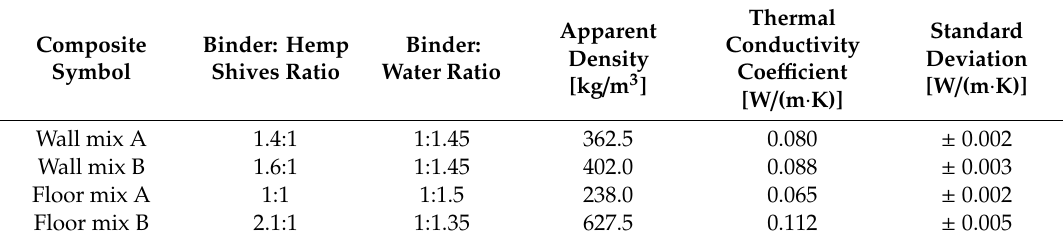
Table 1. Recipes of hemp–lime mixes (weight ratio), apparent density and thermal conductivity of the tested